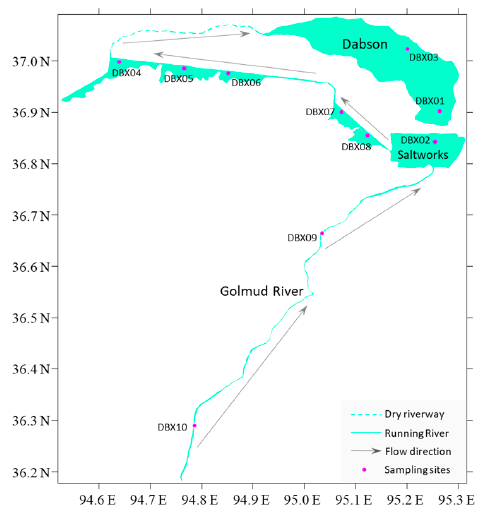
Figure 1. Location of the sampling sites and the flow direction.